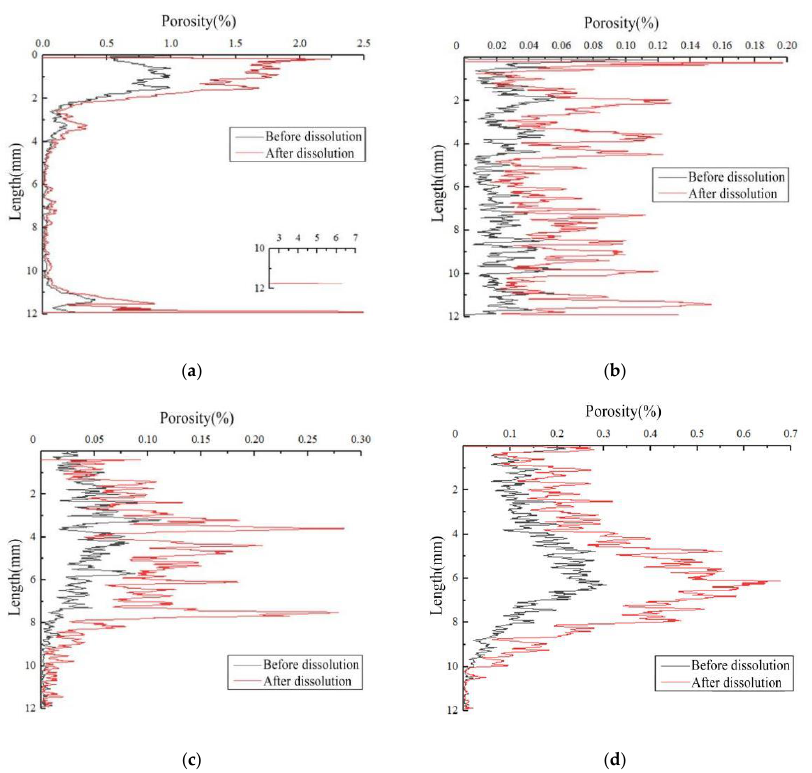
Figure 8. Changes of porosity distribution of carbonate samples before and after dissolution: ( a ) sample 5#, ( b ) sample 6#, ( c ) sample 7#, and ( d ) sample 8#.